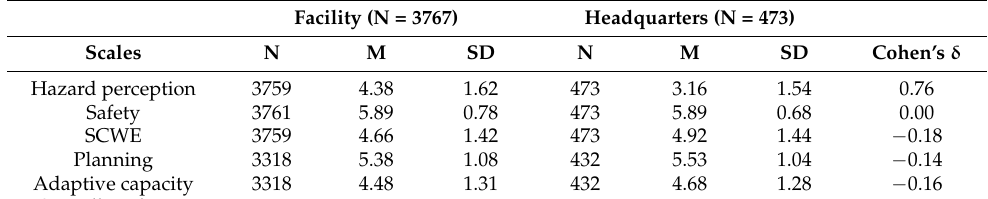
Table 8. Descriptive statistics of the scales by work location.